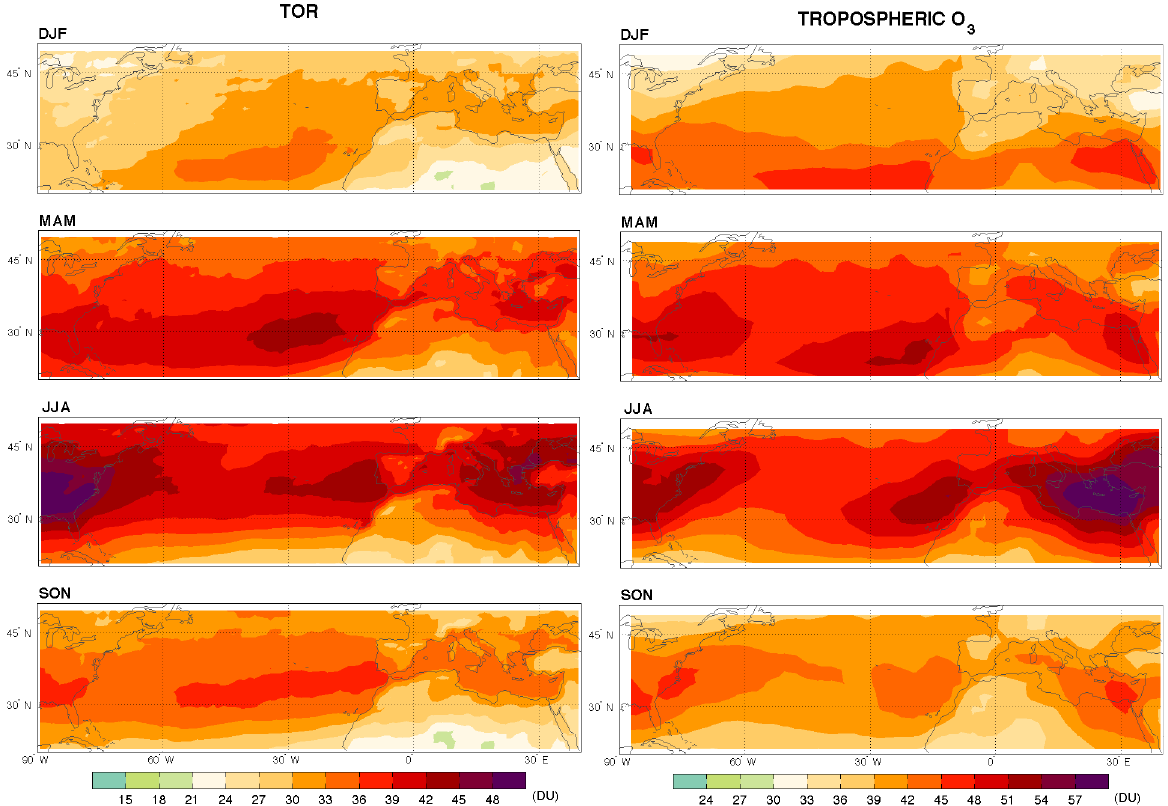
Fig. 3. Climatological (1980–2005) tropospheric ozone residual (left) and modeled tropospheric O 3 burden (right) in the North Atlantic for each season. Note the use of different colorscales to emphasize pattern